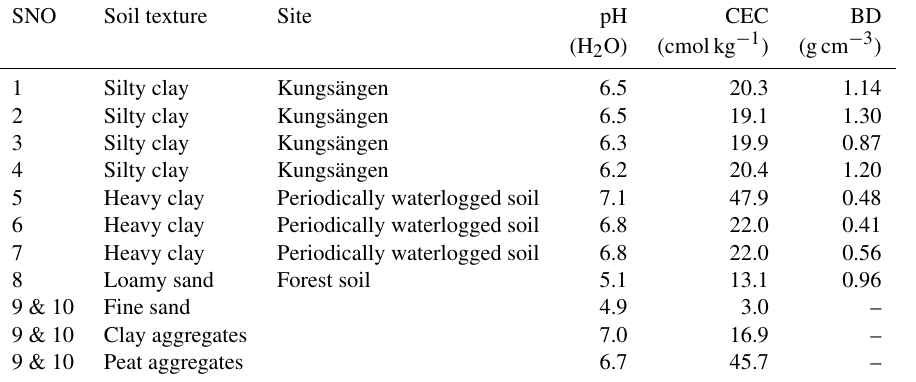
Table 2. Soil texture classes, sampling site, pH, cation exchange capacity (CEC NH SNO Soil texture